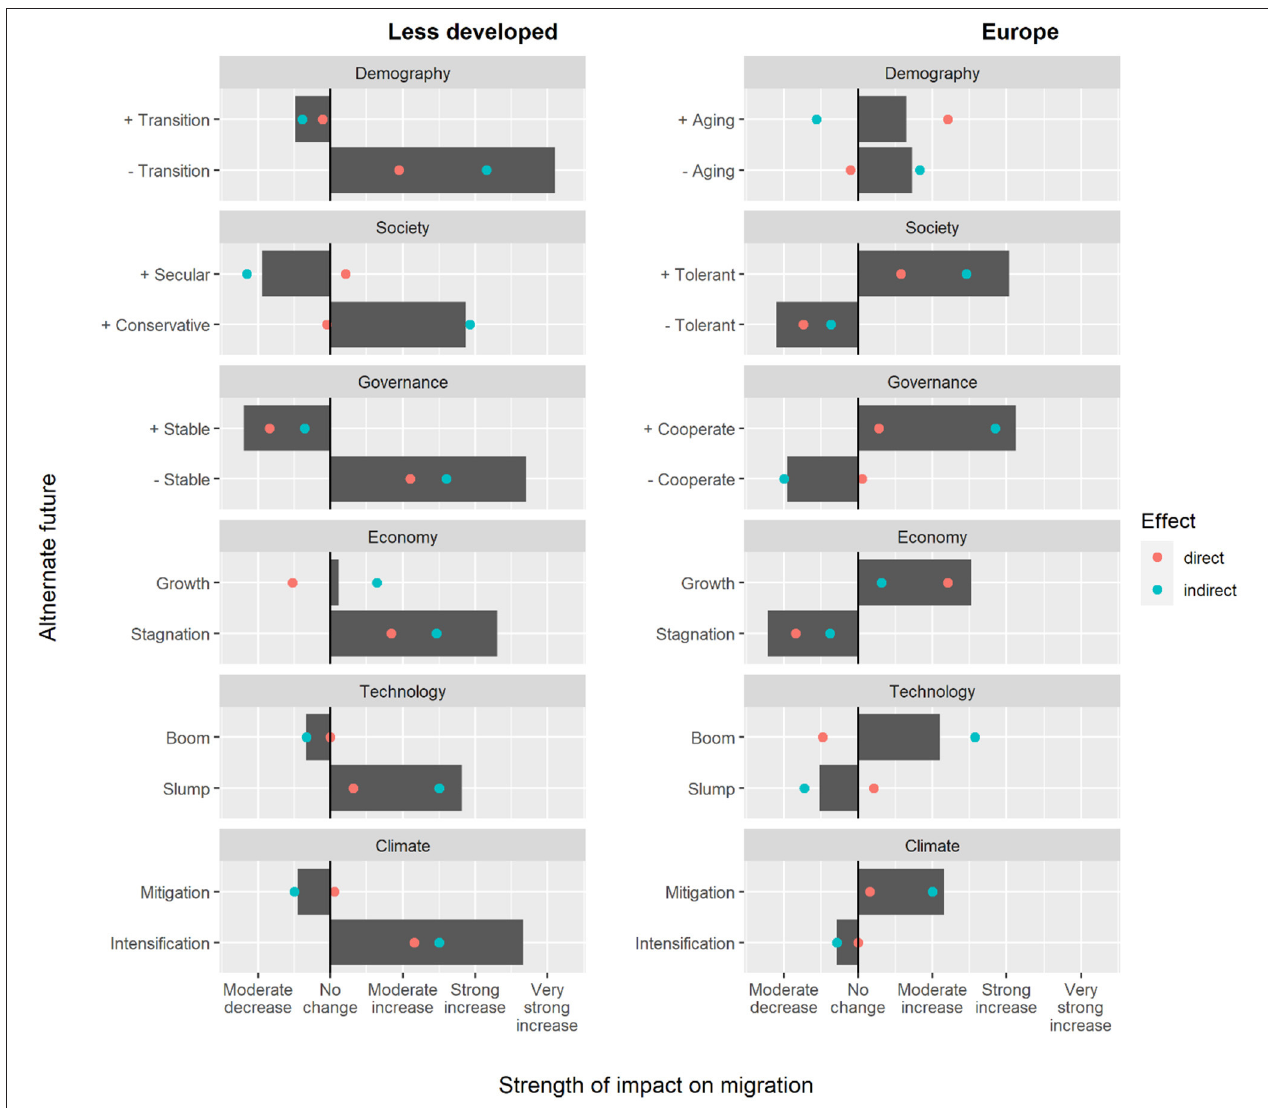
FIGURE 3 | Direct, indirect, and net impact on migration of each scenario in each driver. Direct impacts correspond to the values shown in Tables 1 , 2 . Indirect impacts are the row sums of the impacts shown in Figures 1 , 2 , which calculations are based on the exact values found in Tables 1 , 2 . The left hand part of the figure shows results about the pressure to migrate from less developed countries while the right one shows results about the demand for migrants in Europe. Dots are color-coded and represent direct and indirect effects. Bars represented net effects, which are the sum of direct and indirect